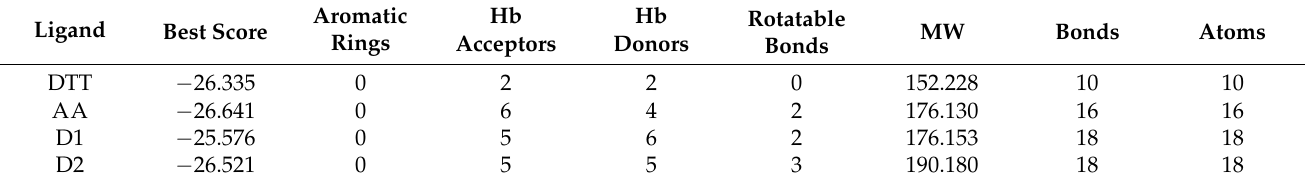
Table 1. The docking scores and structural data for dithiothreitol (DTT), AA, NH 2 AA (D1), and CH 3 NHAA (D2). The table lists the number of aromatic rings (aromatic rings), the number of hydrogen bond acceptors (Hb acceptors), the number of hydrogen bond donors (Hb donors), the number of rotatable bonds (rotatable bonds), the molecular weight (MW), the number of bonds (bonds), and the number of atoms (atoms) for each analyzed constituent.